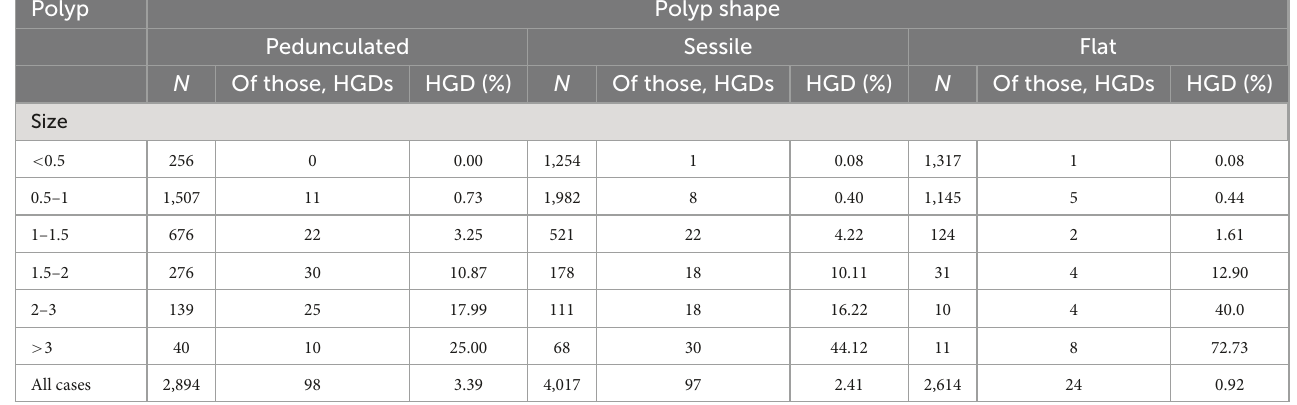
TABLE 3 Size distribution of adenoma